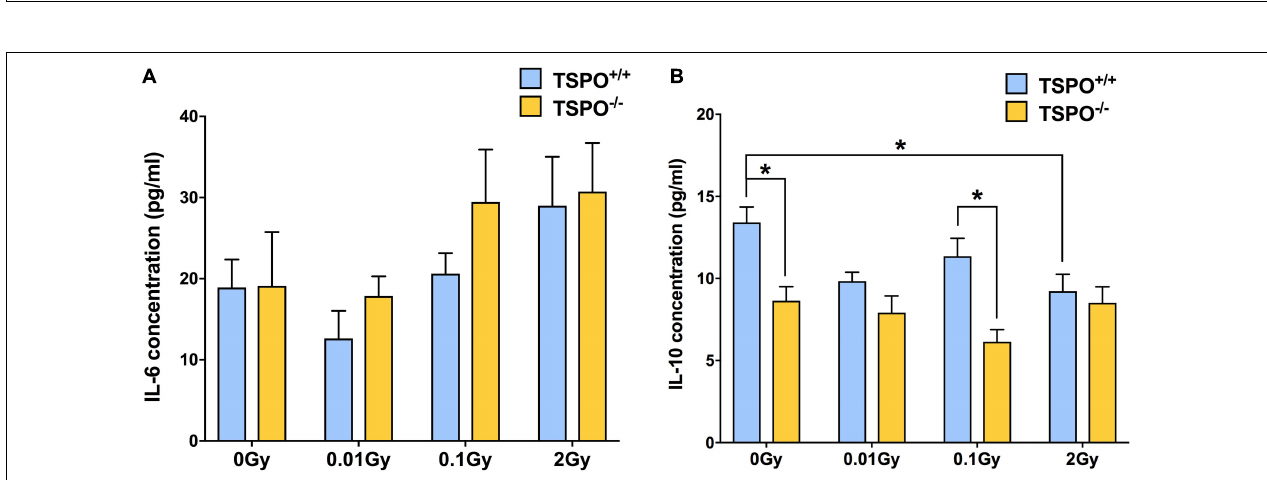
FIGURE 5 | Effect of whole body gamma irradiation on plasma IL-6 and IL-10 expression levels in wild type ( Tspo + / + ) and TSPO knockout ( Tspo − / − ) mice. (A) ELISA analysis demonstrated greater IL-6 expression in both Tspo + / + and Tspo − / − plasma after 2 Gy relative to 0 Gy controls, though this did not reach statistical significance ( p > 0.05). A trend toward downregulation in IL-6 concentration after 0.01 Gy irradiation in Tspo + / + plasma was observed, though levels in Tspo − / − plasma remained comparable to 0 Gy. (B) IL-10 concentration decreased in Tspo − / − plasma across all doses compared to Tspo + / + , though this was only statistically significant in control and 0.1 Gy plasma (* p < 0.05). IL-10 concentration was also significantly decreased in Tspo + / + 2 Gy relative to 0 Gy control (* p < 0.05). Data are presented as mean and standard error, n = 6–9 mice/group.